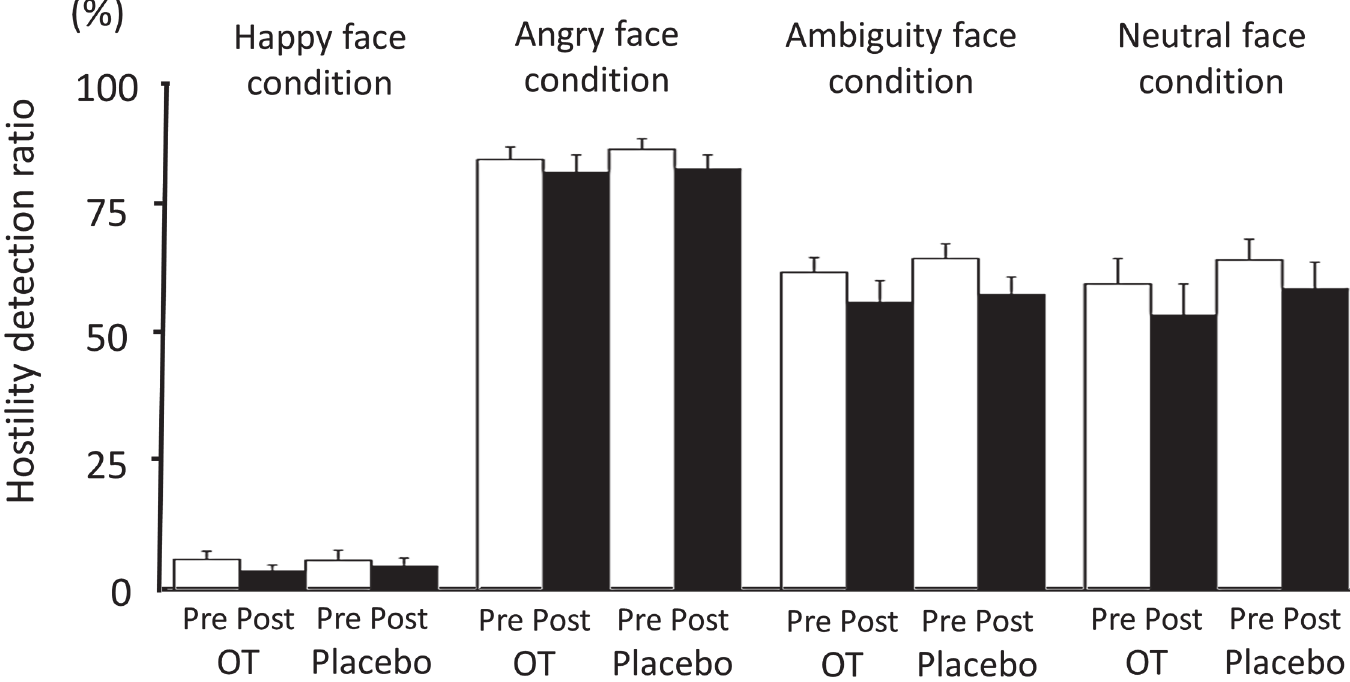
Fig 3. The hostility detection ratio (a lower value indicates a positively valenced interpretation of the facial expression) pre- (white bar) and post- treatment (black bar) with OT or placebo. A, happy face condition. B, angry face condition. C, ambiguous face condition. D, neutral face condition. Two- way ANOVA (treatment × drug) revealed significant treatment effects (i.e., order effects) under the ambiguous and neutral conditions but not under the happy or angry condition. We failed to detect an OT-related effect on the hostility detection ratio under any condition. The error bars represent 1 standard error.